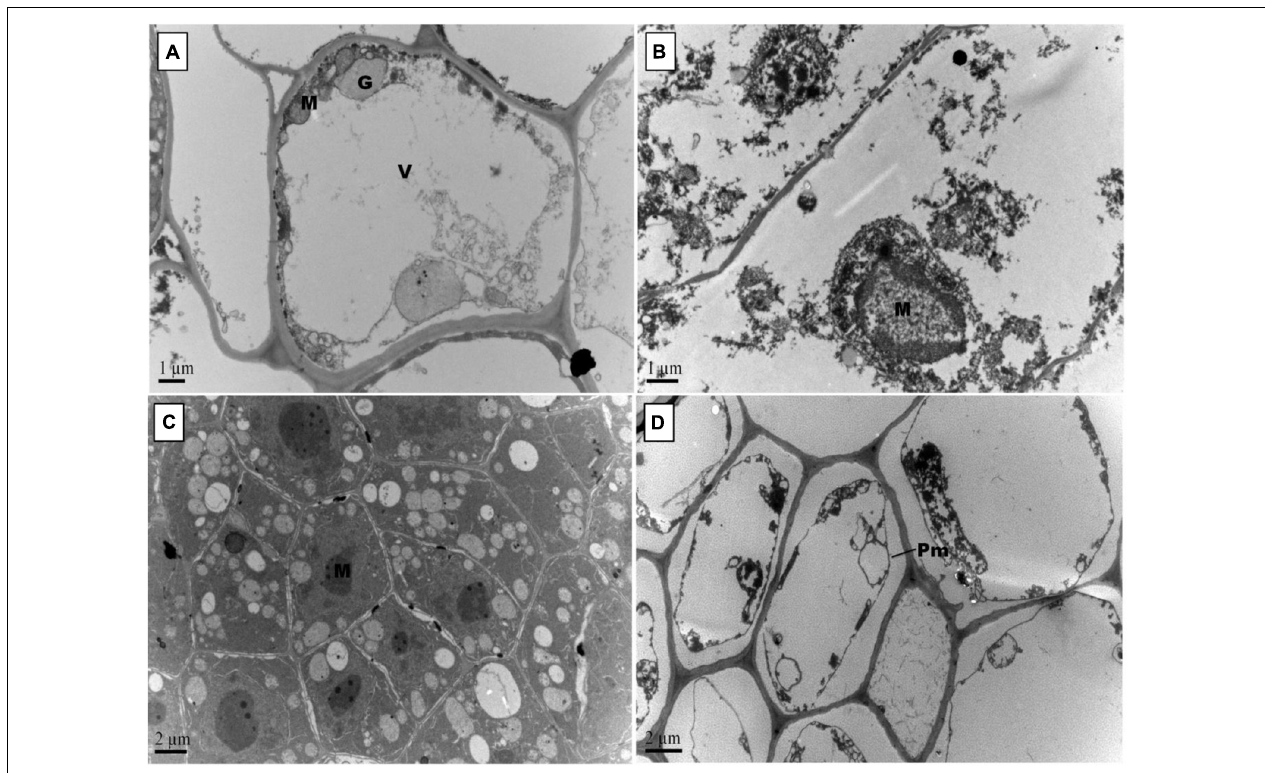
FIGURE 8 | Effect of Pb and GSH on secondary root ultrastructure in upland cotton. Transmission electron micrographs show secondary roots cell morphology of control (A) , 500 µ M Pb (B) , 50 µ M GSH (C) and 500 µ M Pb + 50 µ M GSH (D) in cotton seedlings. Control cells (A) possessed large central vacuole (V), Golgi vesicles (G) and mitochondria (M). In Pb-treated cells (B) , cell morphology was severely altered. GSH-treated roots (C) had developed cell organelles and formation of several multivesicular vesicles. In GSH + Pb (D) , plasma membrane (Pm) was detached from cell wall in almost every